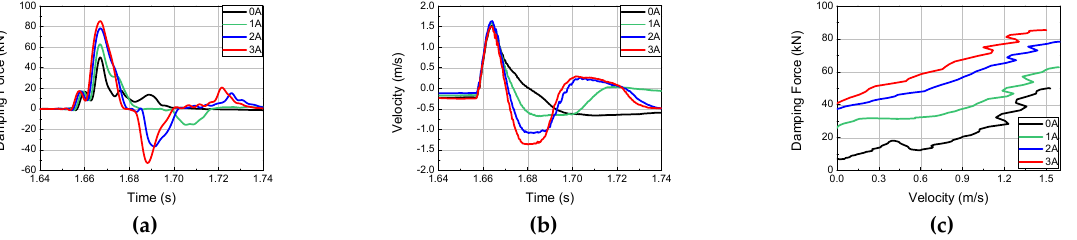
Figure 6. MR damper experimental results at an impact velocity of 2.5 m/s (Test 1): ( a ) Damping force Piston velocity; ( b ) Piston Velocity; ( c ) F-V diagram of MR damper.